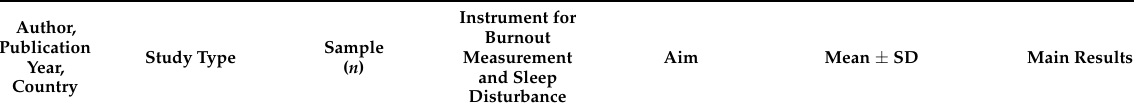
Table 1. Main results included in the